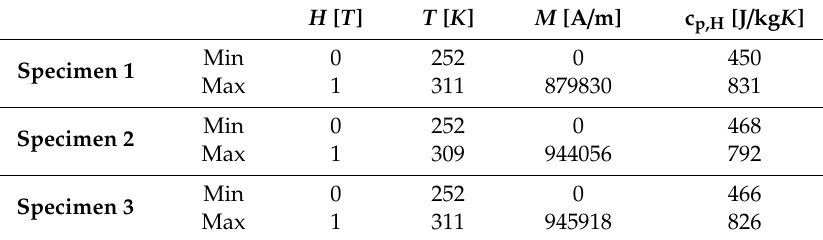
Table A6. Input-target mapping of La-Fe-Co-Si